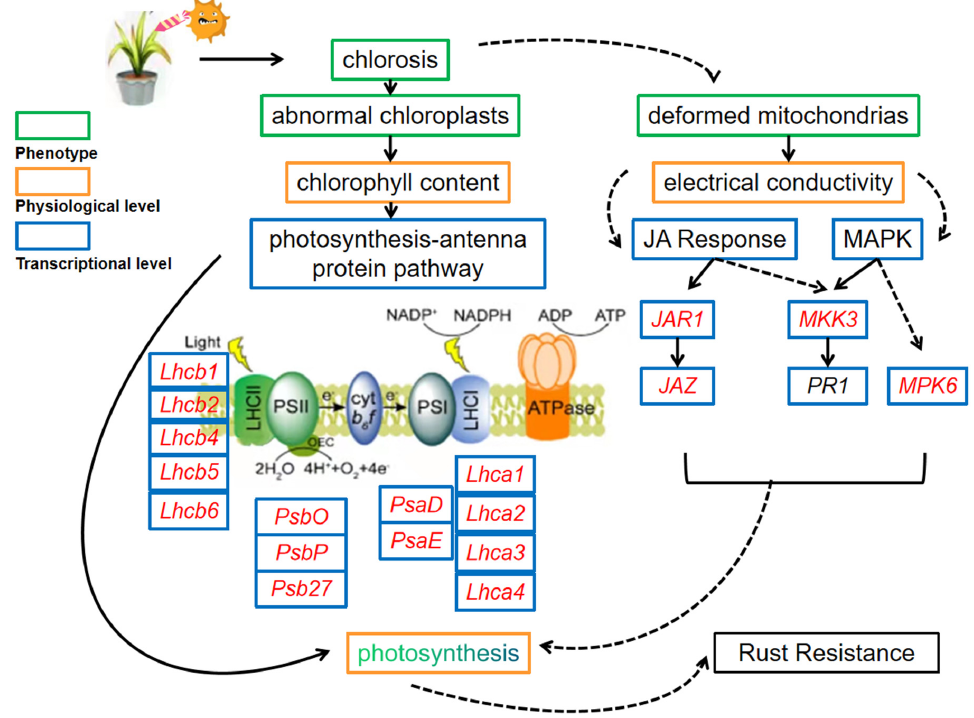
Figure 12. A molecular regulatory scheme of Z. japonica in response to P. zoysiae. Red letters indicate the up-regulated genes. Dotted lines indicate direct or indirect